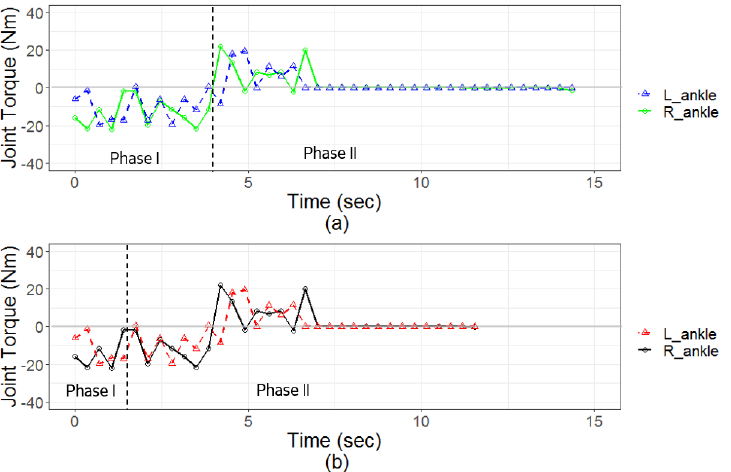
Figure 16. Joint torque measured from the ankle joint using the correct ( a ) and incorrect ( b ) methods of standing